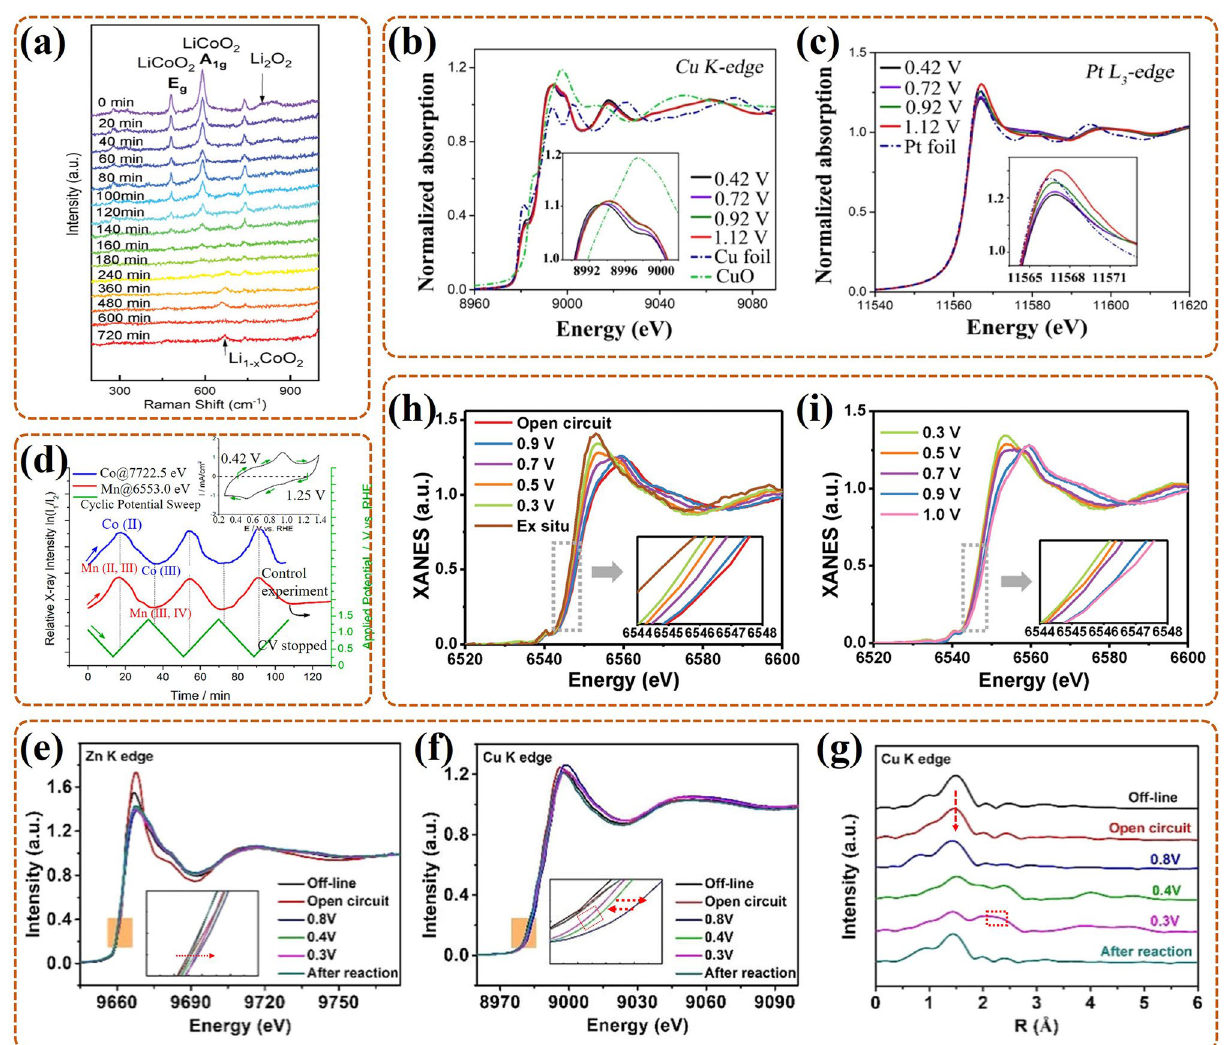
Fig. 6 a In-situ Raman spectrum of LCO in Li–O 2 battery during the first recharge [111]; Reused with approval; Copyright 2020 WILEY- VCH Verlag GmbH & Co. KGaA, Weinheim. b In-situ Cu K-edge XANES spectrum (with Cu foil and CuO standard as reference), c in-situ Pt L 3 -edge XANES (with Pt foil as reference) of Int-PtCuN/KB during ORR in PEMFC [113]. Reused with approval; Copyright 2021 American Chemical Society. d The changes of ln( I 1 / I 2 ) for Co K-edge (at 7722.5 eV) and Mn K-edge (at 6553.0 eV) in Co 1.5 Mn 1.5 O 4 /C under the cyclic potential sweep, with the inset of the CV test [84]; Reused with approval; Copyright 2019 American Chemical Society. In-situ XANES spectra of e Zn K-edge, f Cu K-edge, and g in-situ EXAFS spectrum of Cu K-edge, for the Cu/Zn-NC under several constant potentials [115]; Reused with approval; Copyright 2021 WILEY–VCH GmbH. In-situ XANES spectra of Mn-SAS/CN at potentials h from 0.9 to 0.3 V (also at open cir- cuit and ex situ), i from 0.3 to 0.9 V [116]; Reused with approval; Copyright 2020 WILEY-VCH